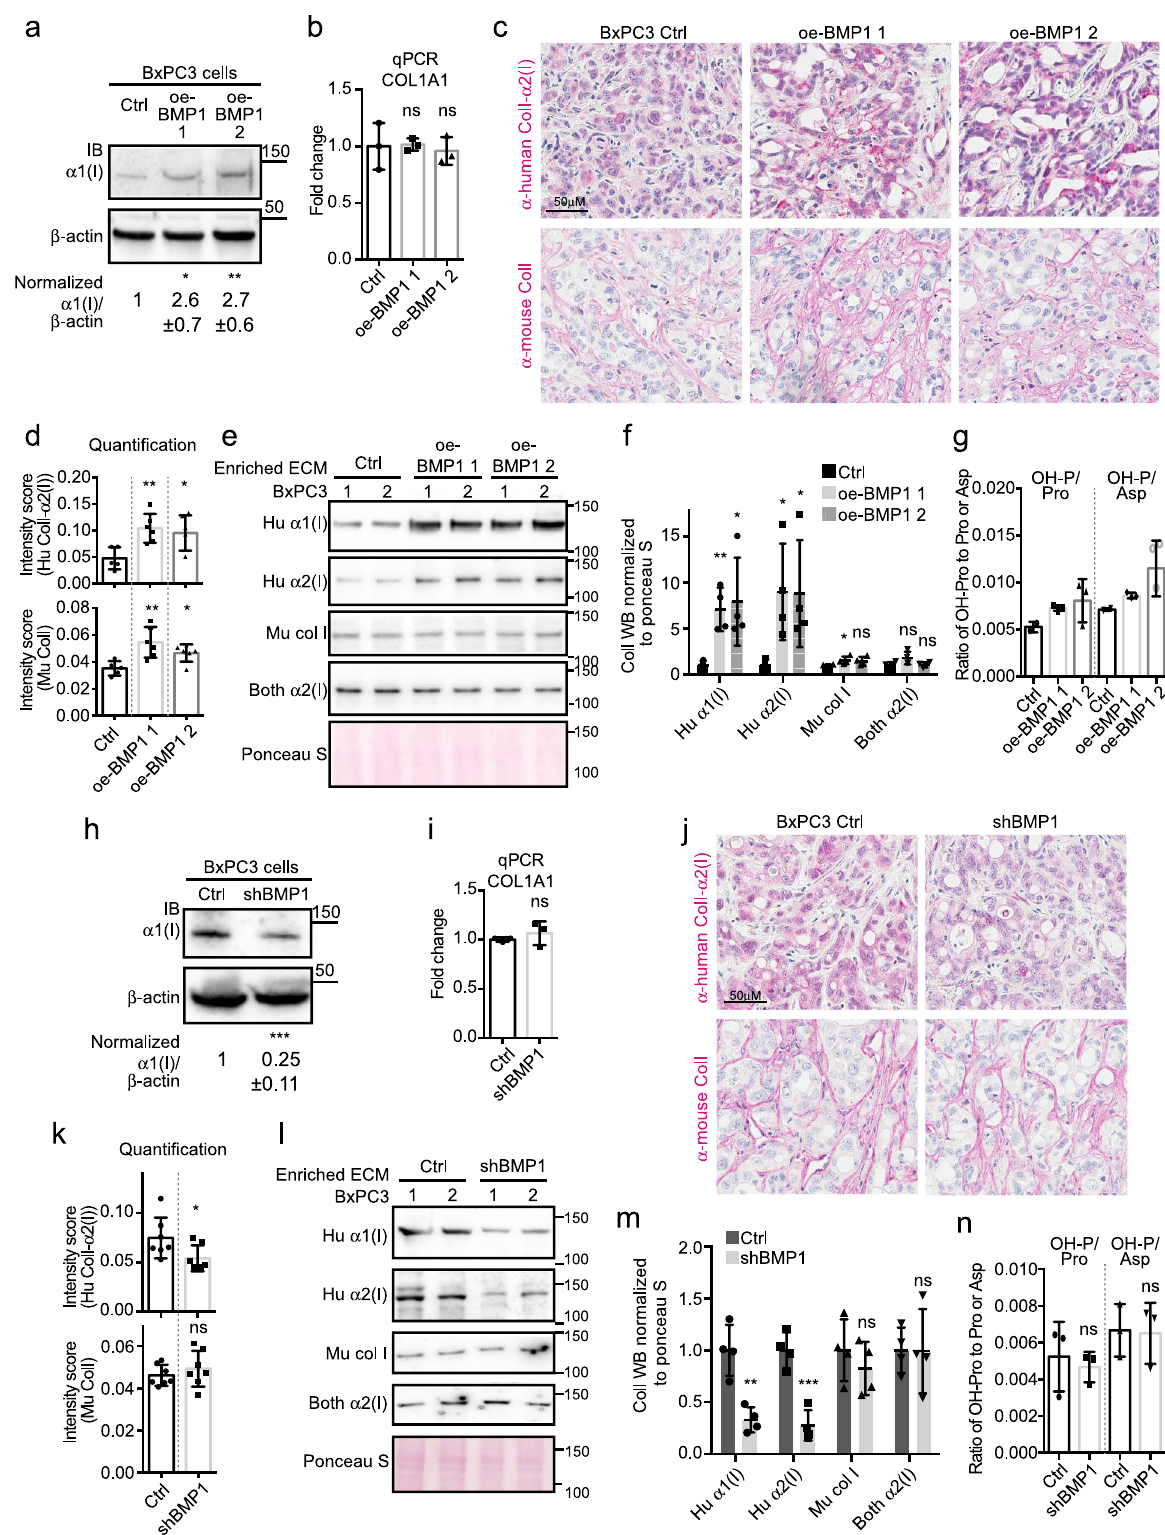
by IHC (Supplementary Fig. 4M) and at the mRNA level by qPCR with validated human-speci fi c primers (Supplementary Fig. 4N – Q). The differential effect of BMP1 in BxPC3, PANC1, and AsPC1 cells suggested cell-intrinsic differences. Among them, PANC1 cells had the highest COL1A1 expression and the